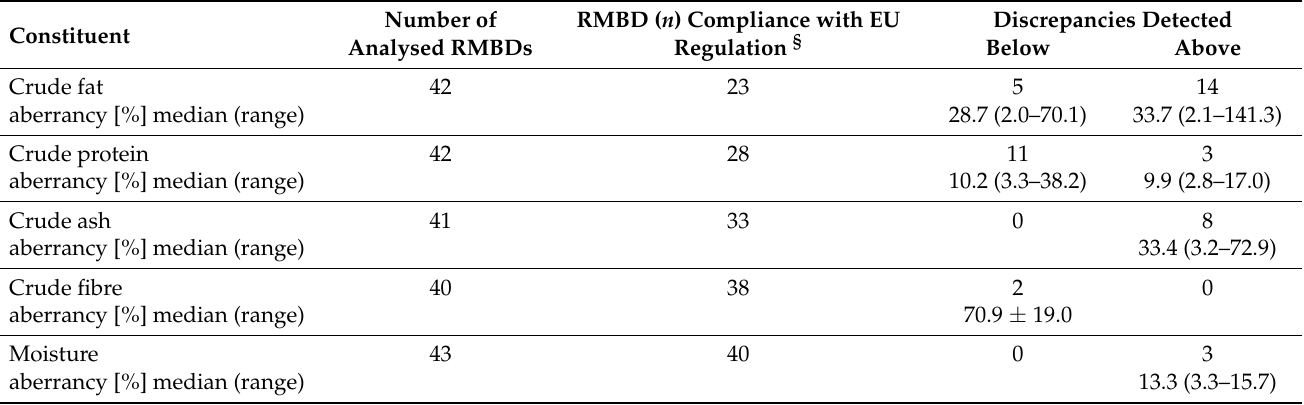
Table 3. Comparison of declared vs. measured analytical constituents in RMBDs in % aberrancy beyond legally tolerated concentrations (EC No 767/2009; Annex IV, part